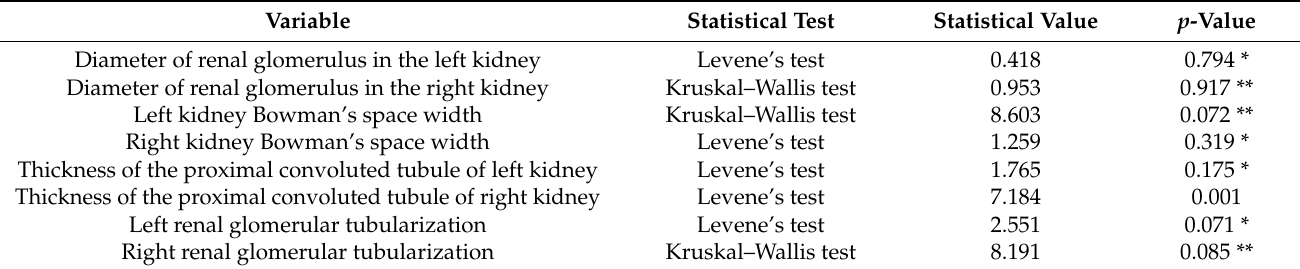
Table 4. The homogeneity test results of data variants with Levene’s test and Kruskal–Wallis test from all left and right kidneys variables in the treatment mice